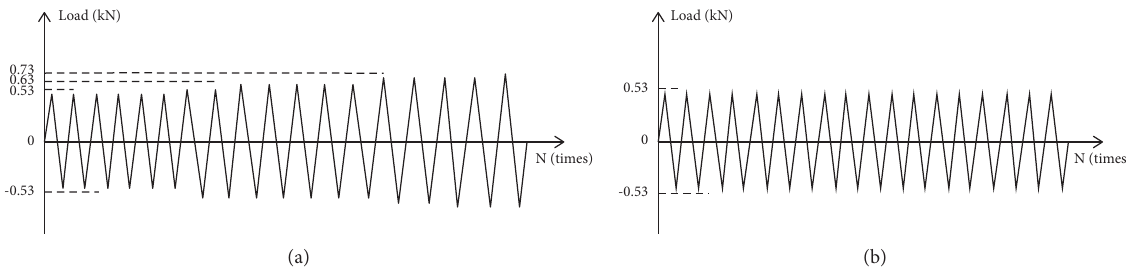
Figure 5: Time history curves of two loading modes. (a) Multi-stage cyclic loading. (b) Single-stage cyclic